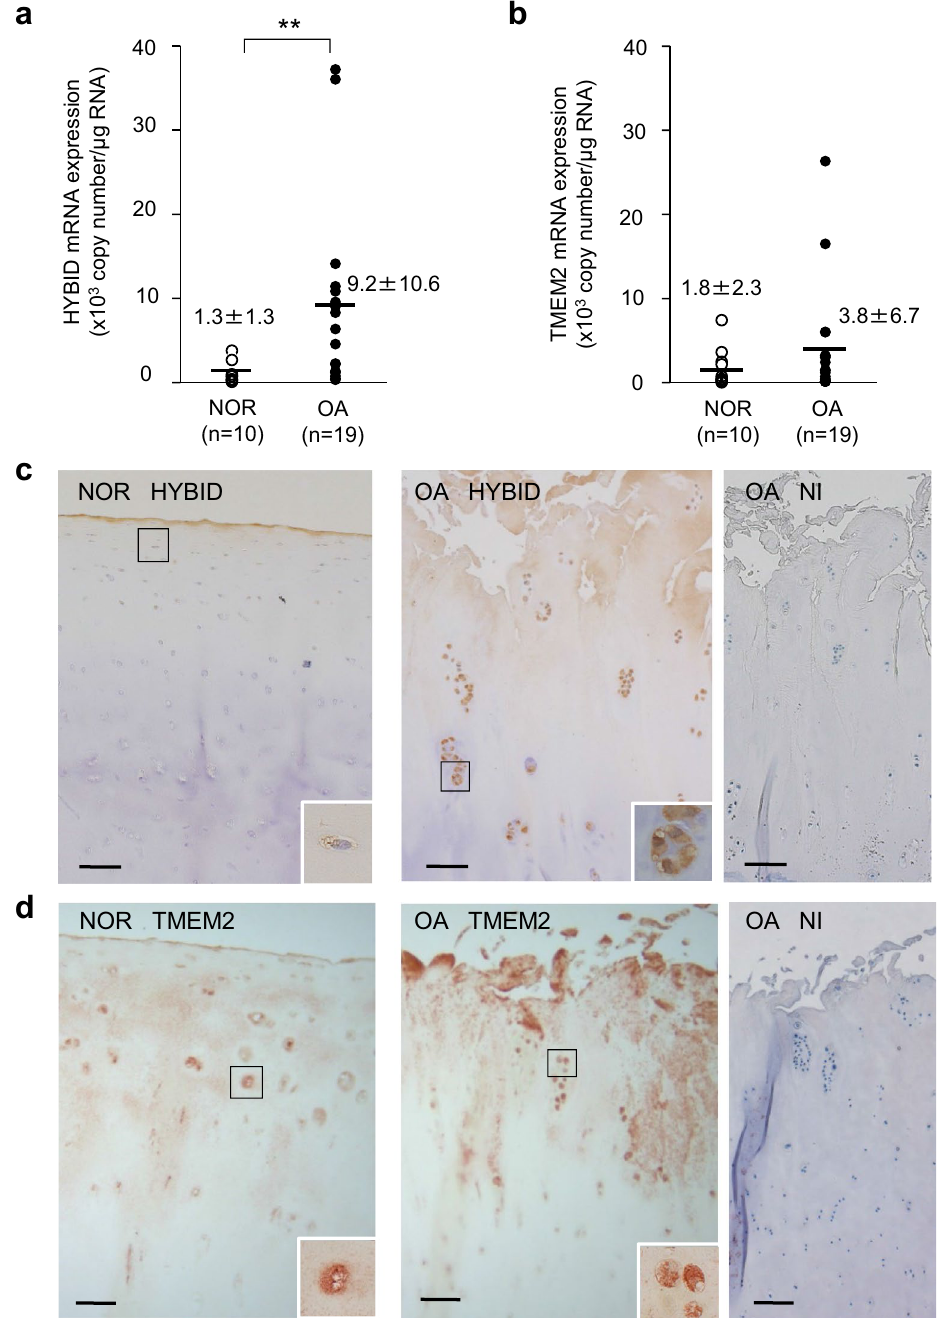
Figure 1. Expression of HYBID and TMEM2 and their tissue localization in human articular cartilage. ( a ) and ( b ) Copy numbers of HYBID and TMEM2 transcripts in control normal (NOR) and OA cartilage samples. The copy numbers were determined by quantitative real-time PCR assay with standard curves generated from reference plasmids. Symbols represent individual subjects, and horizontal lines indicate means. **, P < 0.01. ( c ) and ( d ) Immunohistochemistry for HYBID and TMEM2 in human cartilage tissue. Paraffin sections of the NOR and OA cartilage samples were stained with anti-HYBID antibody (HYBID), anti-TMEM2 antibody (TMEM2) or non-immune IgG (NI). Boxed areas are shown at higher magnification in the inset. Scale bars = 200 µm. Full- length images for the inset are presented in Supplementary Figure